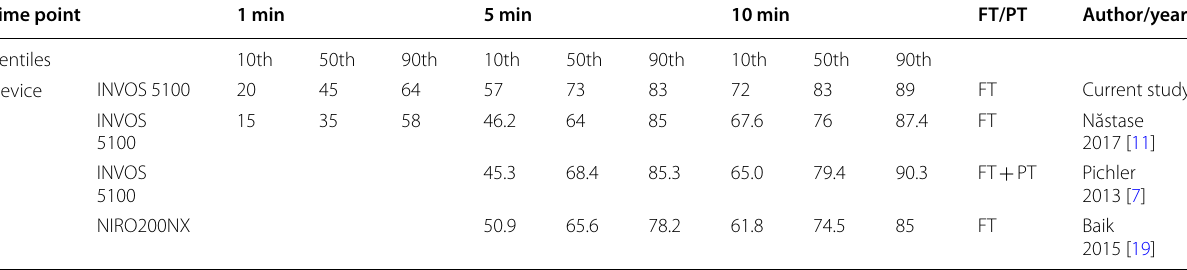
Table 7 Cerebral oxygenation centiles in the two NIRS devices at different time points. The current study shows the highest cerebral oxygenation values at 1, 5, and 10 min, followed by Pichler et al. that included preterm and full‑term infants’ cerebral oxygenation values in their